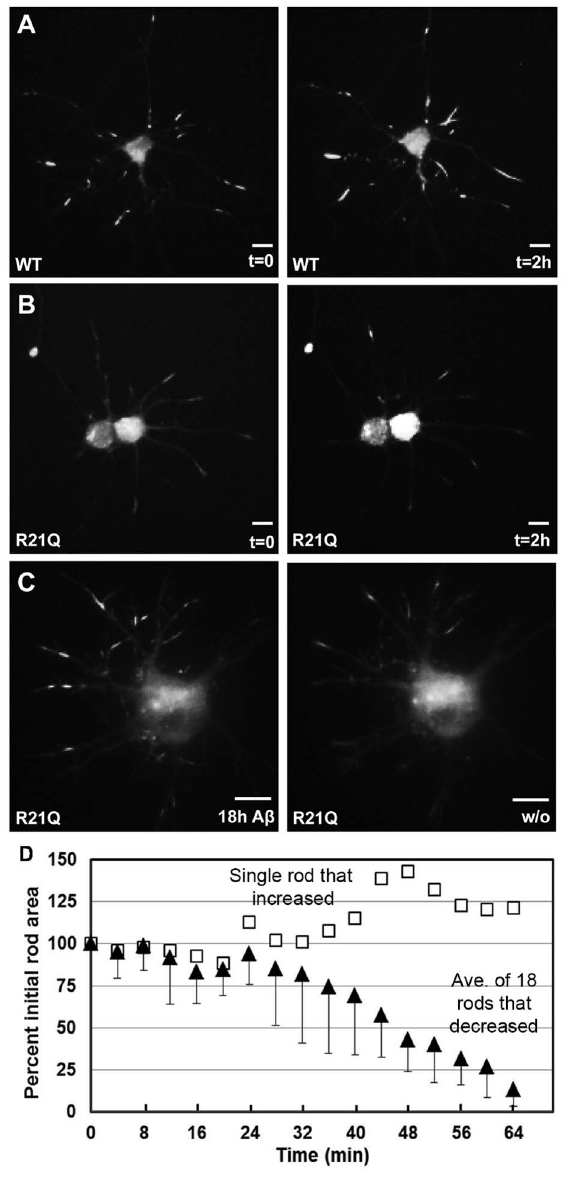
Figure 6. Visualization of rod formation and disappearance in neurons. Panels from time lapse imaging of neurons expressing cofilin-wt-mRFP (A) or cofilinR21Q-mRFP (B, C). In (A), neurons expressing cofilin-wt-mRFP had spontaneous rods present before imaging and acquired more rods due to photostress during the 2 h of imaging at 30 s intervals. Under identical imaging conditions, neurons expressing cofilinR21Q-mRFP had few spontaneous rods before imaging and did not form new rods during imaging (B). When cofilinR21Q-mRFP expressing neurons were treated with A b d/t, formation of induced rods could be followed (C) that disappeared following removal of the A b d/t (image of washout (w/o) is at 60 min). Scale bars =10 m m. (D) Disappearance of cofilinR21Q-mRFP rods induced by 18 h A b d/t-treatment in images taken at 4 min intervals after A b d/t washout (filled triangles). Total area of 18 rods in three separate neurons is plotted vs time after washout as a percent of the area at washout. The half-life of rods following A b d/t removal is , 47 min. One rod, in a separate neurite of a neuron that contained reversible rods in other neurites, was found to increase in size (open squares) and is presumed to be a spontaneous rod.